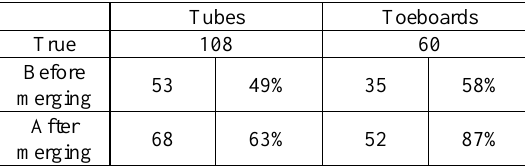
Table1. The number of reconstructed objects